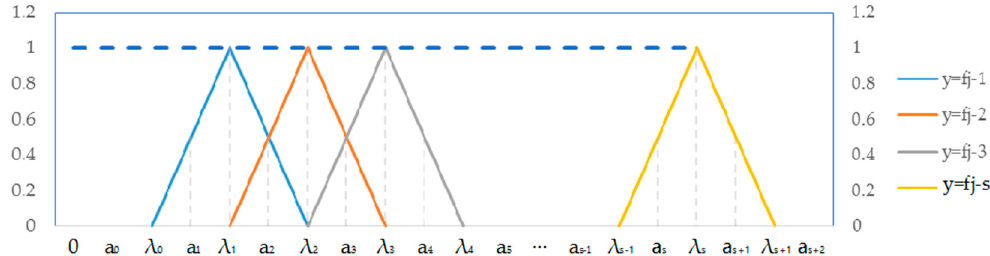
Figure 4. Schematic diagram of the endpoint triangle whitenization weight function.